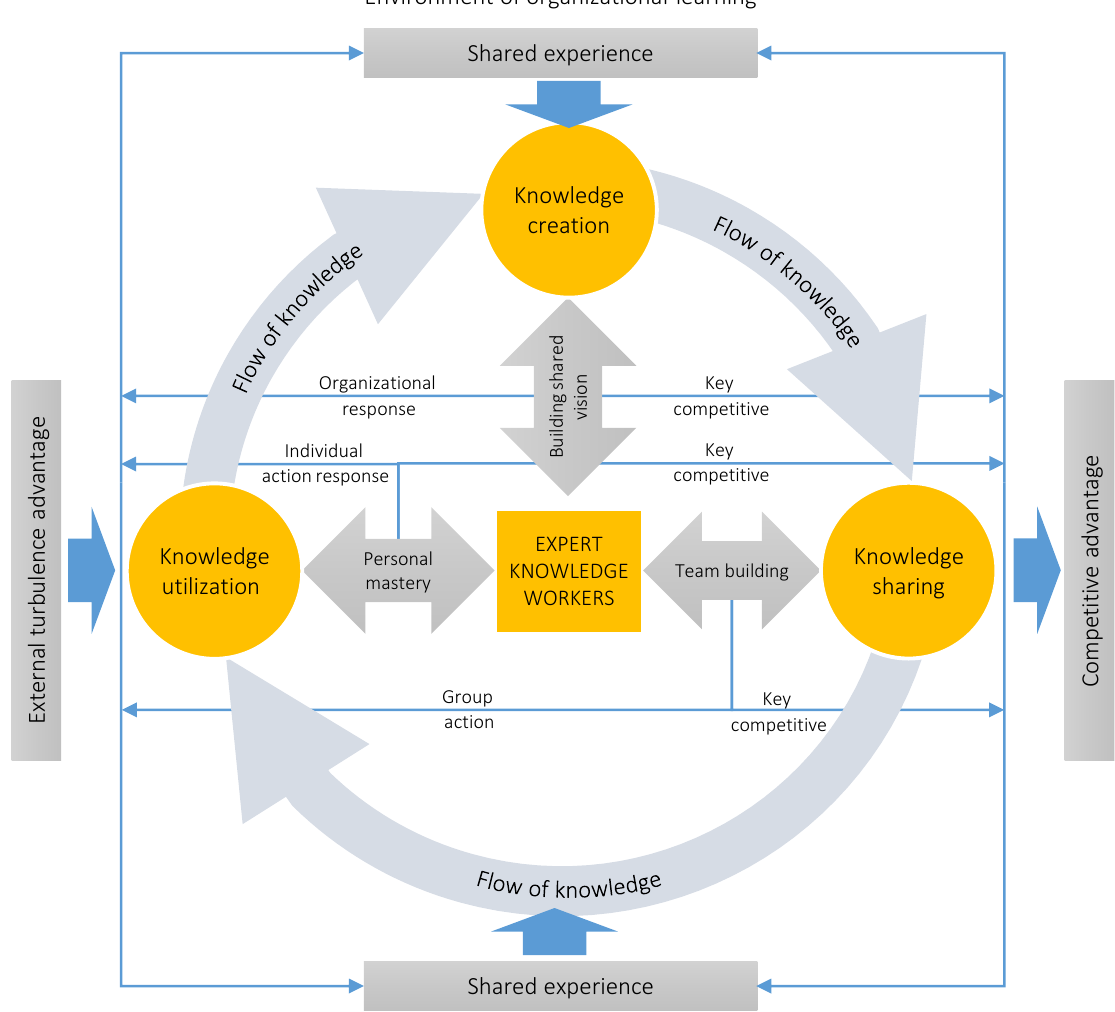
Figure 1. Proposed conceptual model for the current